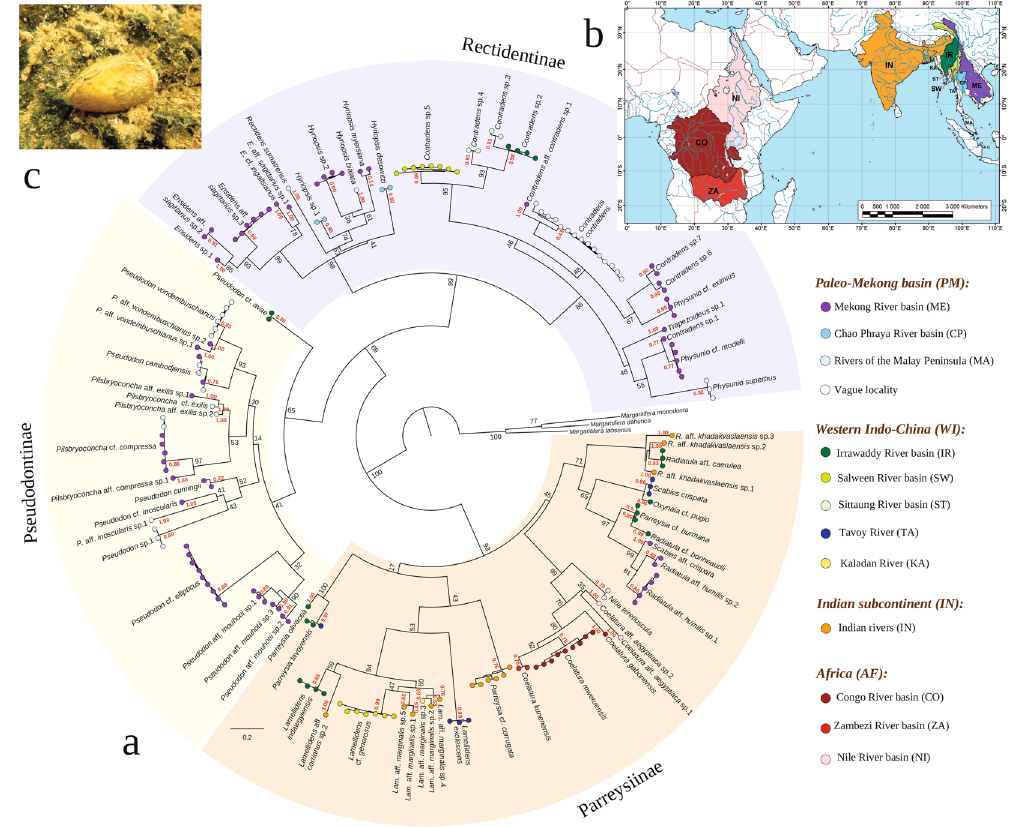
Figure 4. Spatial patterns in the biodiversity of the Unionidae from the Oriental Region and related African taxa discussed in this study. ( a ) Maximum likelihood tree of unique haplotypes obtained from RAxML HPC Black Box v. 8.2.9. Color circles correspond to the distribution range of each haplotype. Red numbers near terminal nodes are support values for each prospective species (MOTU) based on the Bayesian PTP model. Black numbers near other nodes are ML support values. The list of sequences is presented in Supplementary Table 1. ( b ) Map of the primary distribution areas of the Unionidae. The map was created using ESRI ArcGIS 10 software (www.esri.com/arcgis); the topographic base of the map was created with Natural Earth Free Vector and Raster Map Data (www.naturalearthdata.com). ( c ) Live specimen of Parreysia cf. burmana , Irrawaddy River catchment, Myanmar (Photo: Ivan N.